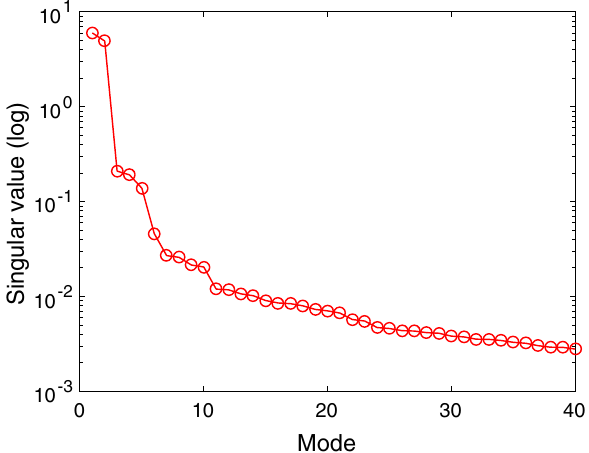
FIG. 8. Singular values of the first 40 SVD